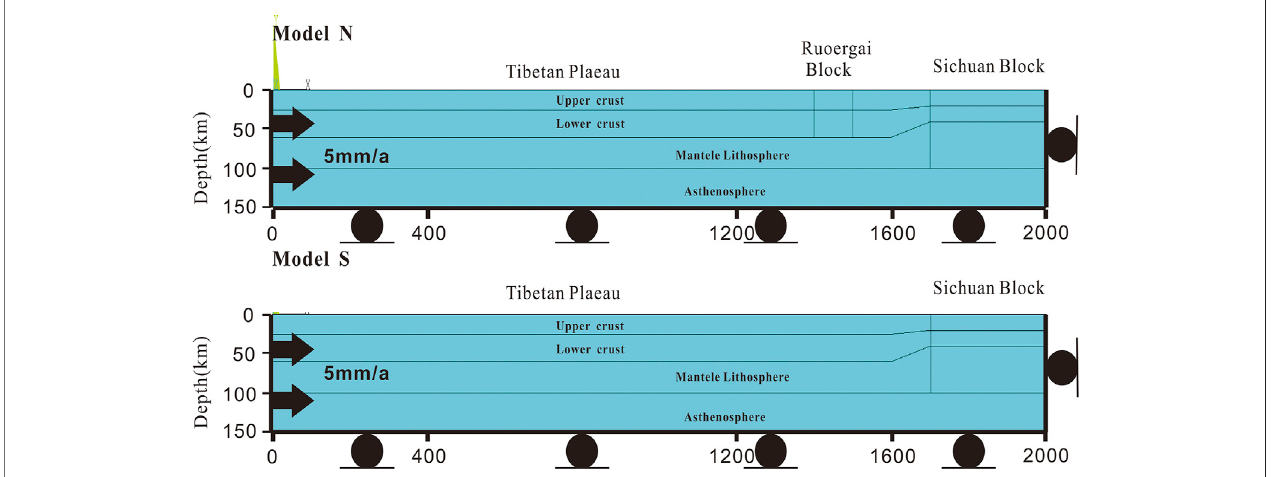
FIGURE 2 | Two two-dimensional reference models crossing the southern Longmen Shan fault (Model S) and the northern Longmen Shan fault (Model N).